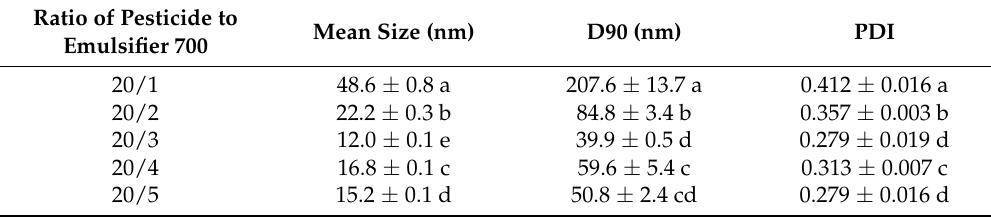
Table 2. The effect of surfactant concentration on the particle size and PDI of